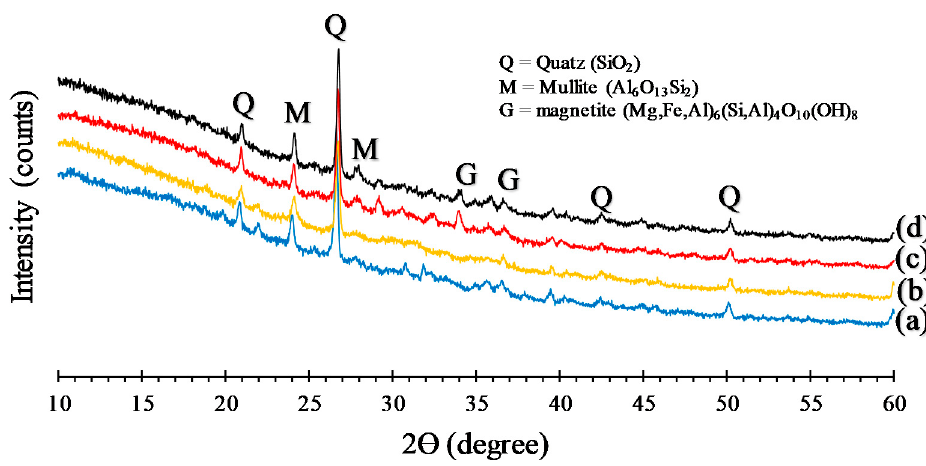
Figure 12. X-ray diffraction patterns of geopolymer paste: ( a ) 0 wt% nanosilica, ( b ) 2 wt% nanosilica, ( c ) 3 wt% nanosilica, ( d ) 4 wt% nanosilica.